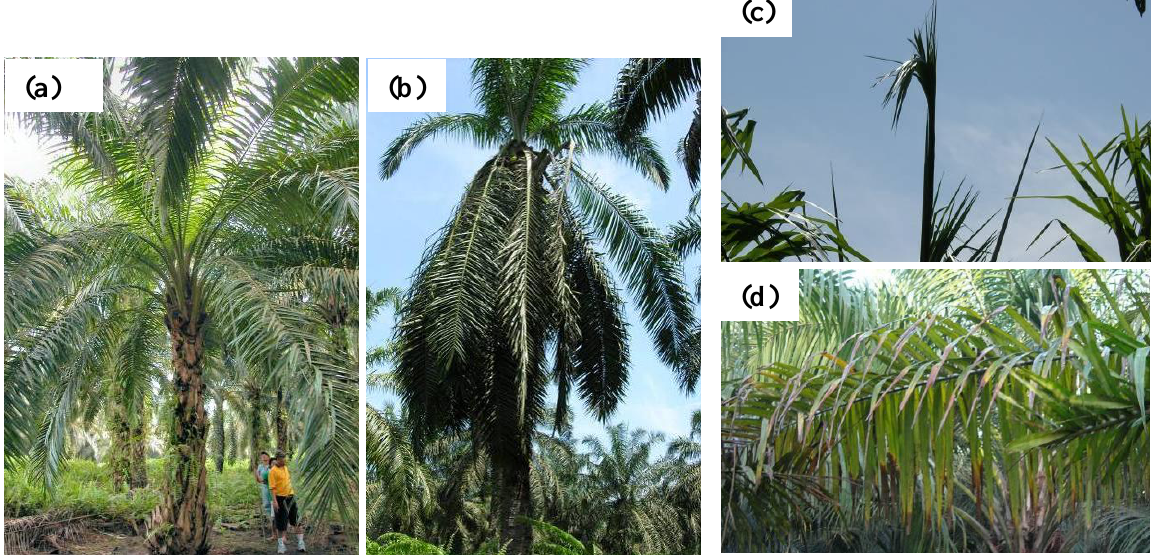
Figure 2. Oil palm trees in Padang Halaban Estate (Indonesia): (a) Healthy tree, (b) tree attacked by ganoderma: the lower leaves have reclined to form a skirt-like crown, (c) several unopened spears at the top of a sick tree canopy, (d) yellowing and early necrosis on leaves of a sick